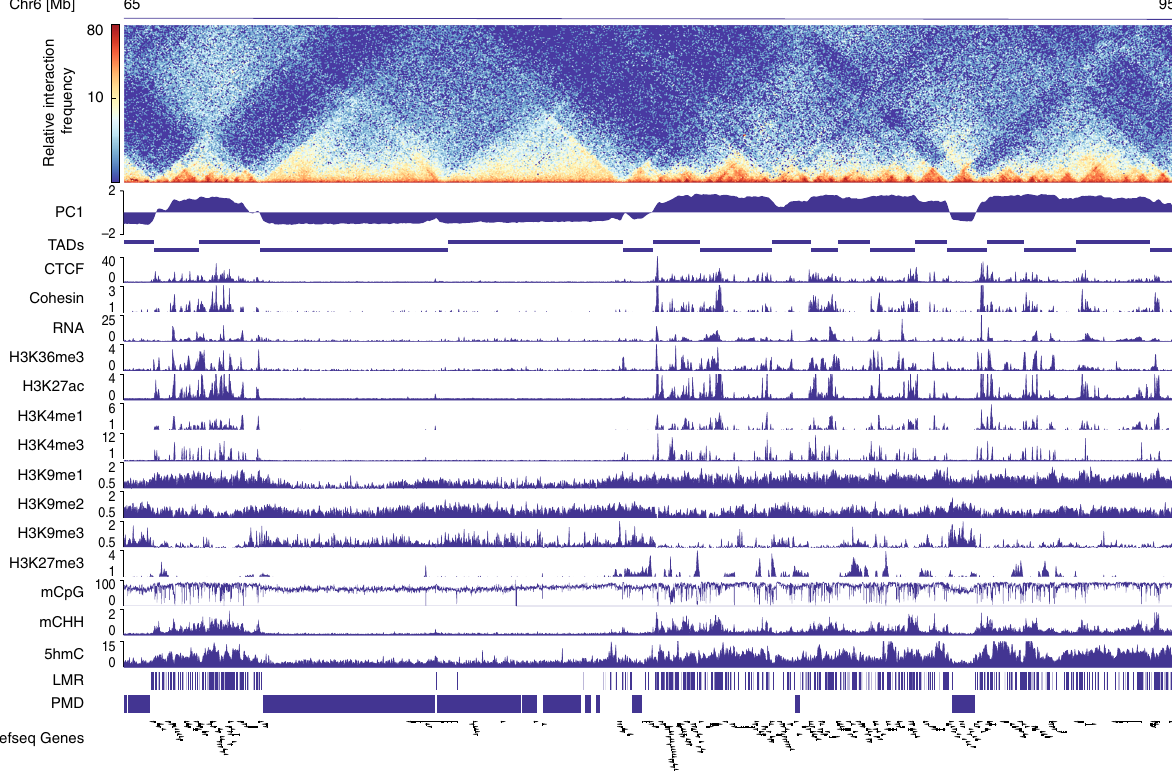
Fig. 1 Distinct DNA methylation patterns in A and B compartments in adult CM. Hi-C contact maps uncover topologically associated domains (TADs) and multi-TAD A/B compartments in adult CM. Principal component analysis characterizes the A/B status of compartments (A, PC1 > 0; B PC1 < 0). Histone modi fi cations, CTCF, and the cohesion subunit (SMC1) (RPKM) predict the chromatin state. Presence of RNA expression (FPKM) and marking with H3K36me3, H3K27ac, H3K4me1, H3K4me3 classi fi es A compartments as active. The inactive chromatin status of B compartments is indicated by H3K9me3 enrichment. CpG methylation data (%) shows low-methylated regions (LMRs), characteristic for cis -regulatory elements, and partially methylated domains (PMDs) overlapping with A and B compartments, respectively. Non-CpG methylation (mCHH, %), and 5-hydroxymethylcytosine (5hmC, RPKM) mark A compartments. Data shown are from n = 3 Hi-C, n = 3 RNA-seq, n = 3 WGBS; n = 2 5hmC-seq and n = 1 – 2 ChIP-seq experiments. RPKM reads per kilobase per million, FPKM fragments per kilobase per million mapped